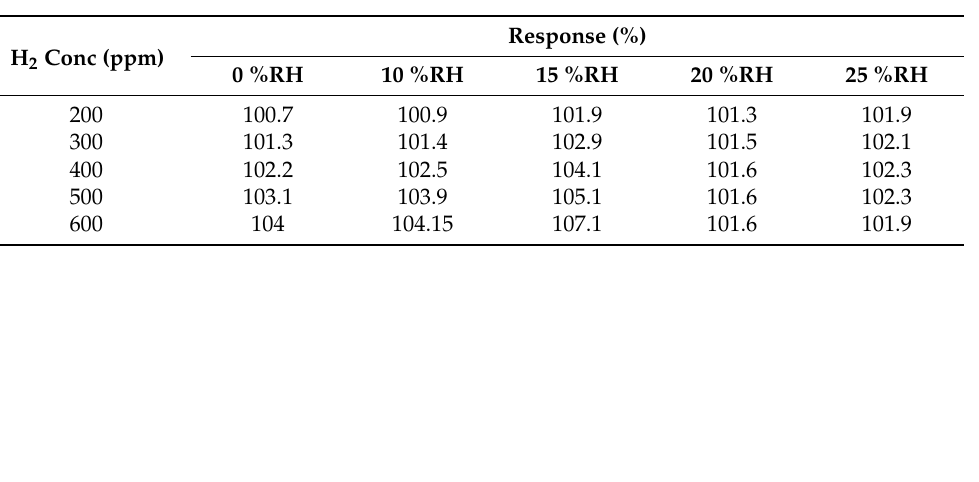
Table 2. Sensing parameters of the sensor towards 200–600 ppm H 2 at 150 ◦ C under UV illumination at different humidity